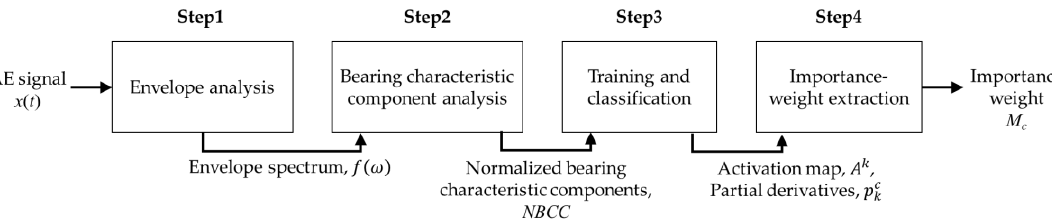
Figure 1. Flowchart of the proposed approach.